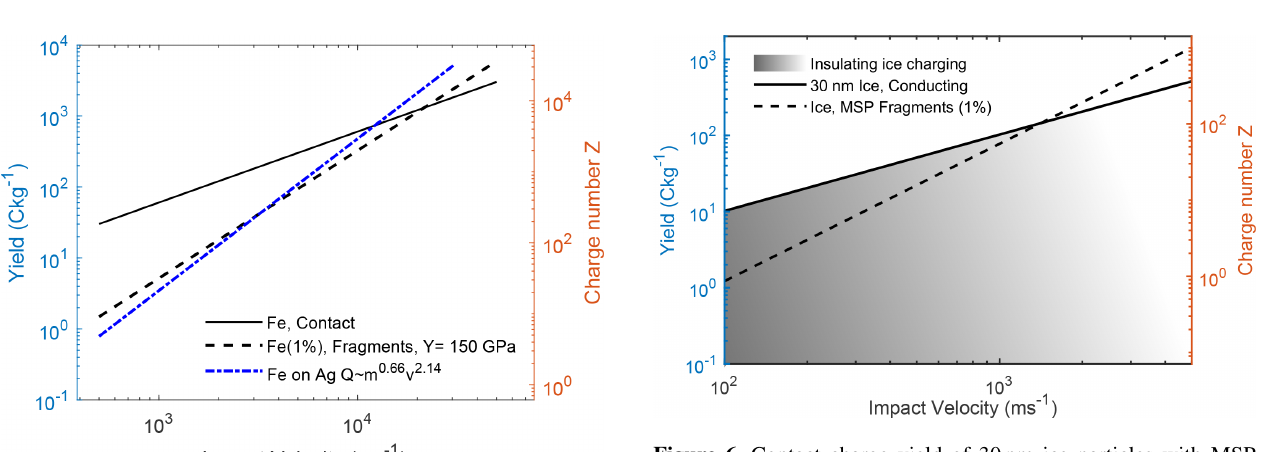
Figure 6. Contact charge yield of 30nm ice particles with MSP impurities impacting on stainless steel. The shaded area shows pos- sible yields for the case of a mixture of insulating and conducting